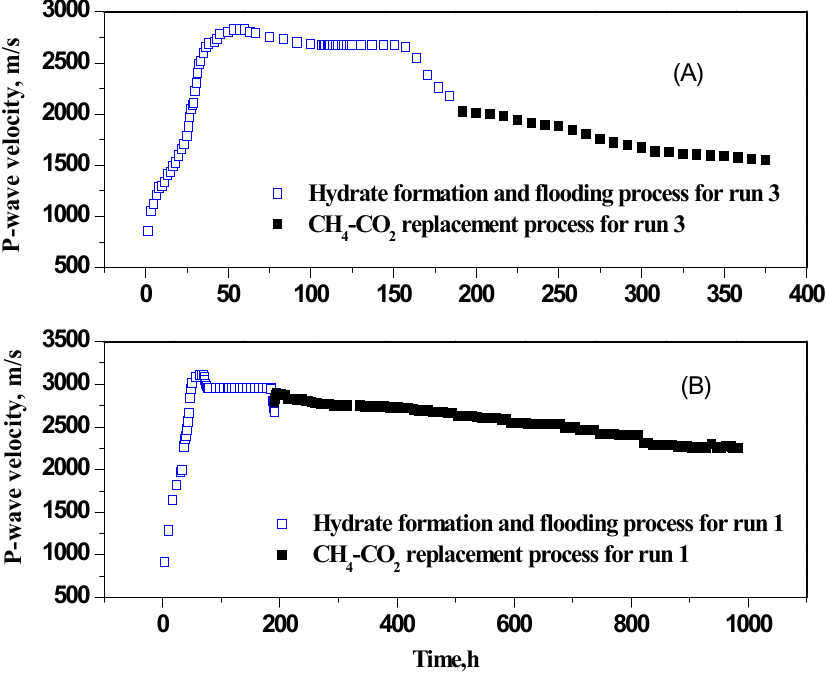
+ 78 mol % N and ( B ) pure gaseous CO 2 2 2